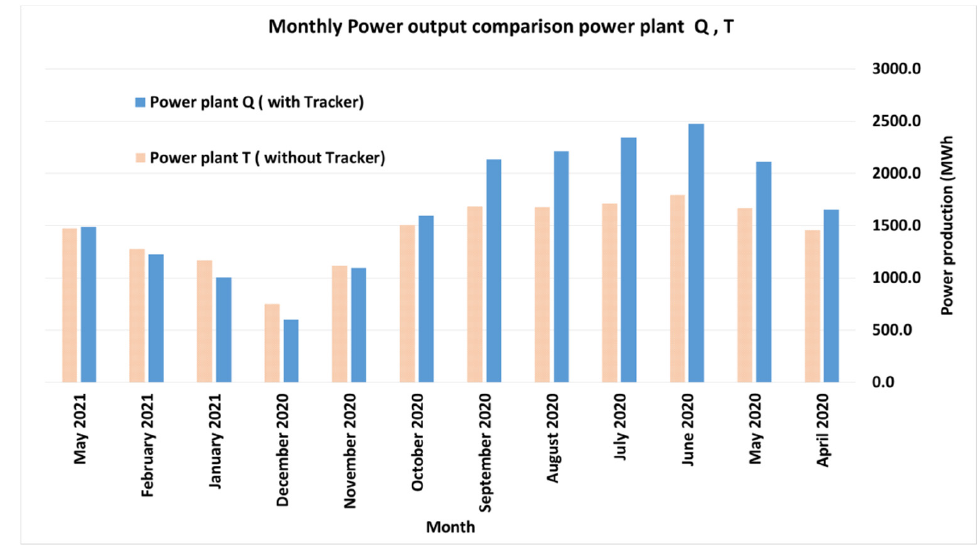
Figure 6. Comparison of monthly energy production of two power plants with (Q) and without tracker (T).